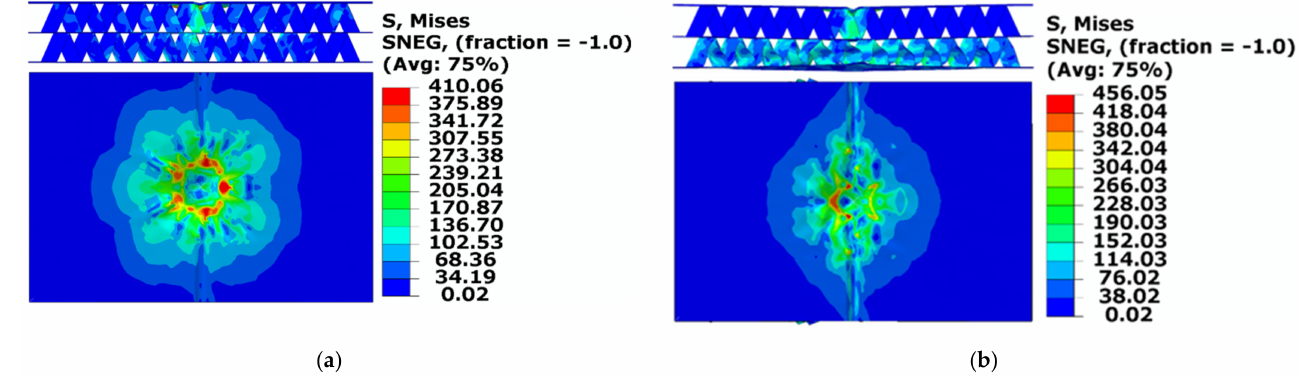
Figure 10. Deformation of double − layer V − shaped folded sandwich structure with increased wall thickness under 40 J impact energy. ( a ) t 1 = 0.3 mm, t 2 = 0.2 mm; ( b ) t 1 = 0.4 mm, t 2 = 0.1